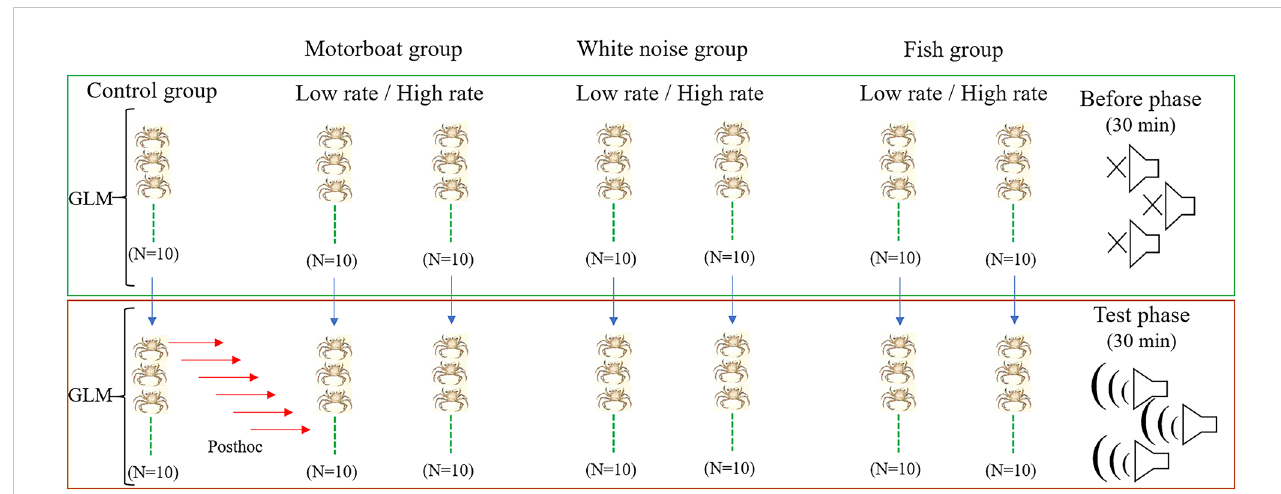
FIGURE 3 Diagram of the experimental design used showing both phases, before and test, with the control and six levels (low and high rate motorboat, low and high rate white noise, low and high rate fi sh) in each phase. For each phase, a GLM was performed. In the test phase, the six red arrows represent the posthoc comparisons between the control and levels. The same design was applied for the three behavioral variables (still position, maternal care ( fl apping + probing) and fl